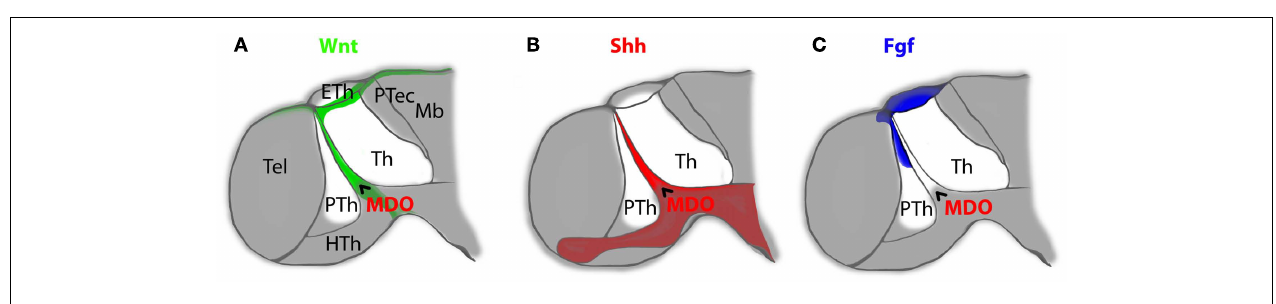
signaling source in the dorsal roof plate.Taken together, these three families of signaling molecules encircle the developing thalamus from dorsal (Wnt and Fgf), ventral (Shh) and rostral (Wnt, Shh, and Fgf).Th, thalamus; PTh, prethalamus; HTh, Hypothalamus; Eth, epithalamus; Tel,Telencephalon; Ptec, pretectum; Mb, midbrain; MDO, mid-diencephalic